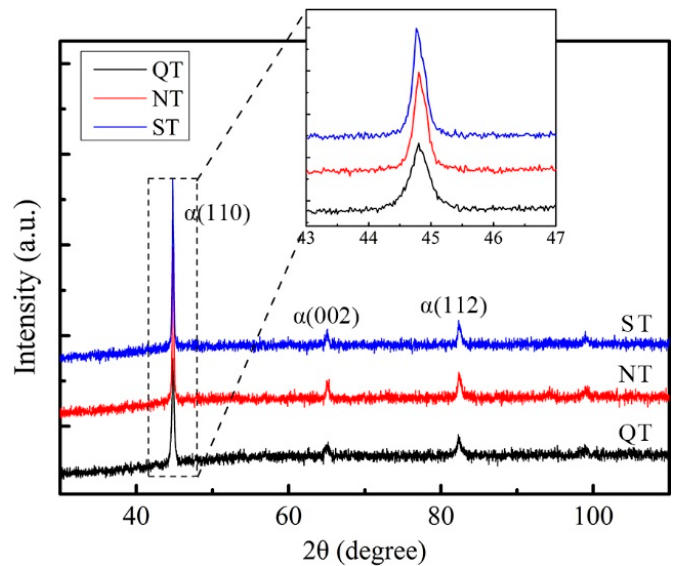
Figure 3. X-ray diffraction (XRD) spectra of QT, NT, and ST.